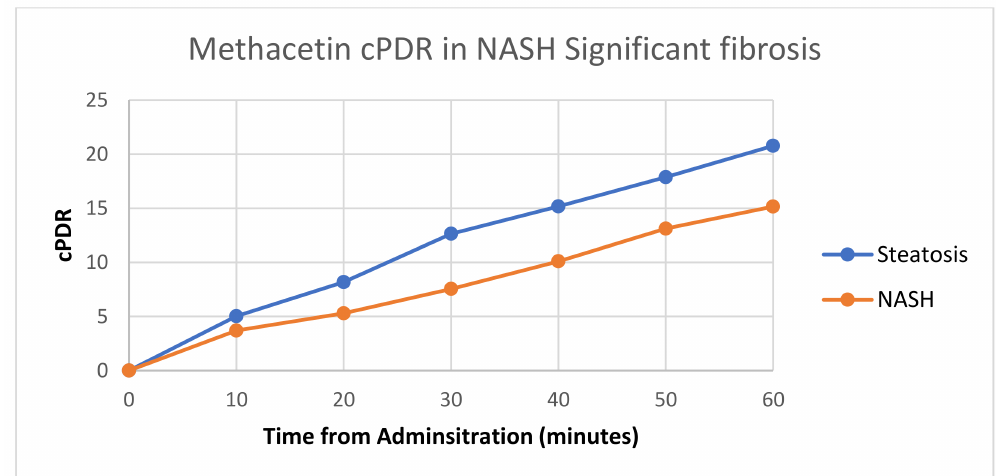
Figure 2. Comparison of cPDR in steatosis vs. NASH for methacetin